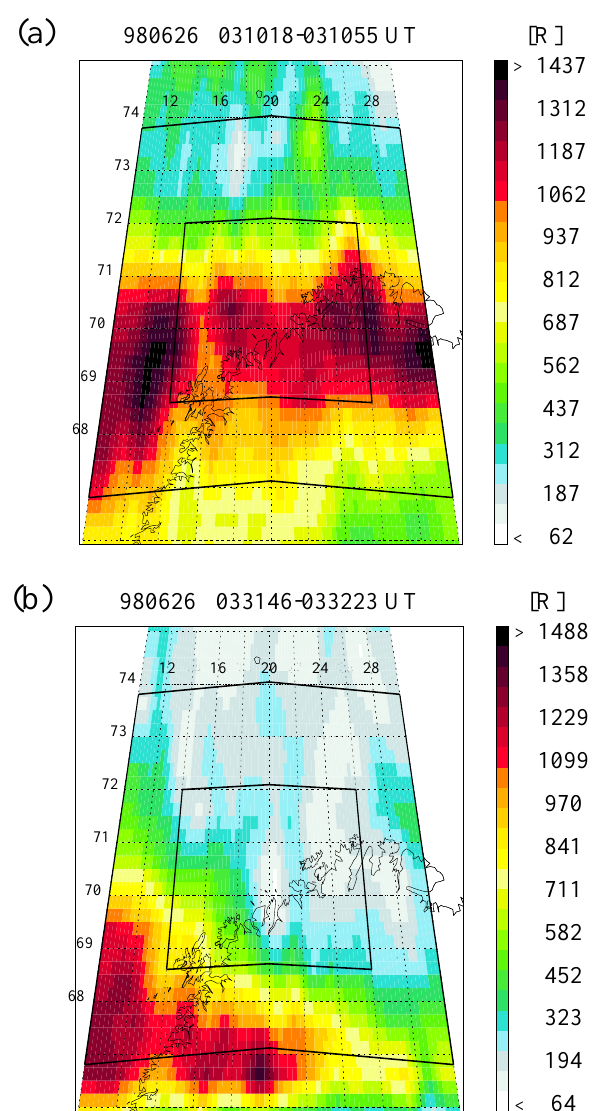
Fig. 7. The UVI-LBHL images for the two time steps of ( a ) 1998. The inner black box drawn on top of the images corresponds to the STARE FOV, while the outer box matches the PIXIE resolu- tion of ∼ 800km.